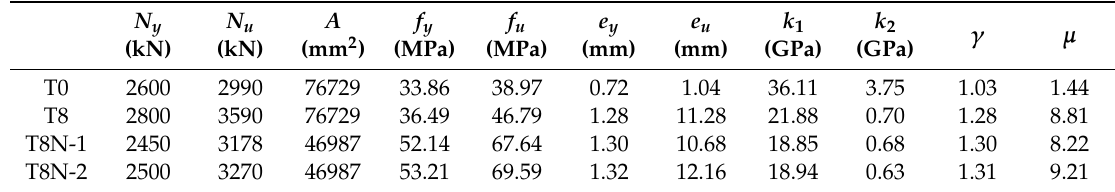
Table 4. Experimental and analytical results of the specimens.